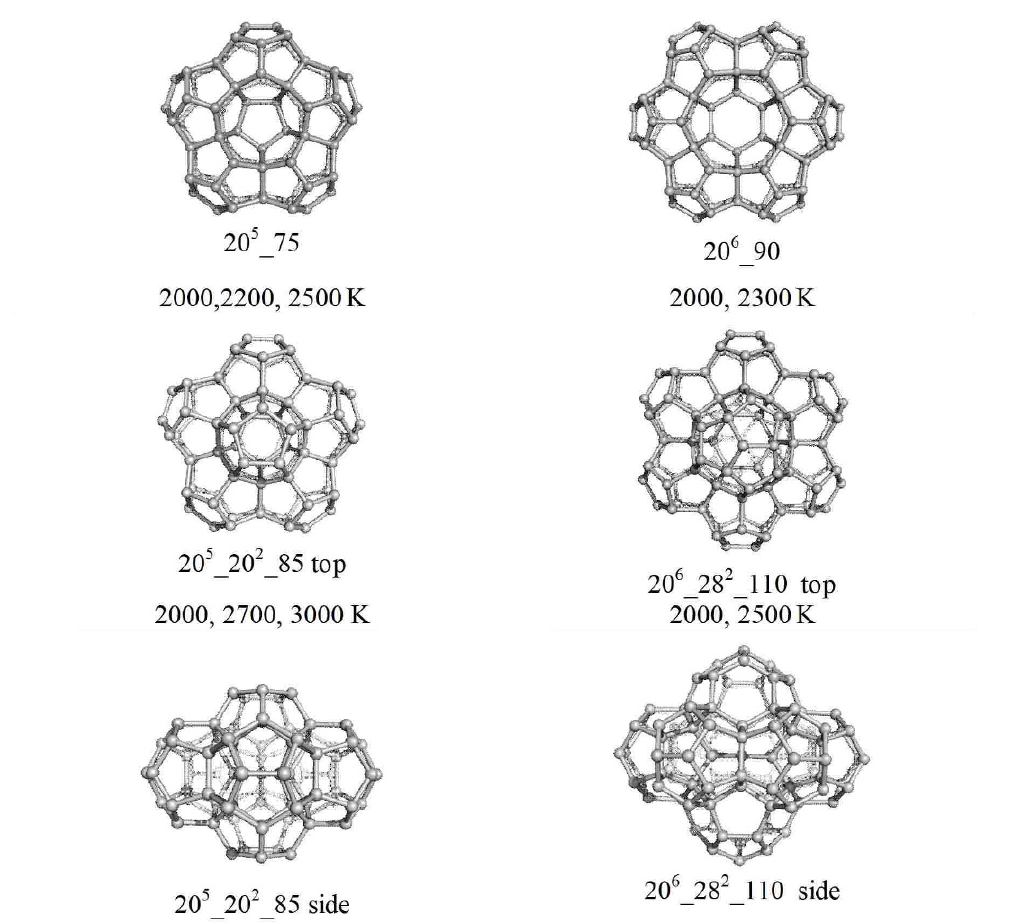
-based structures; 20 6 _28 2 _110 a substructure of D 20